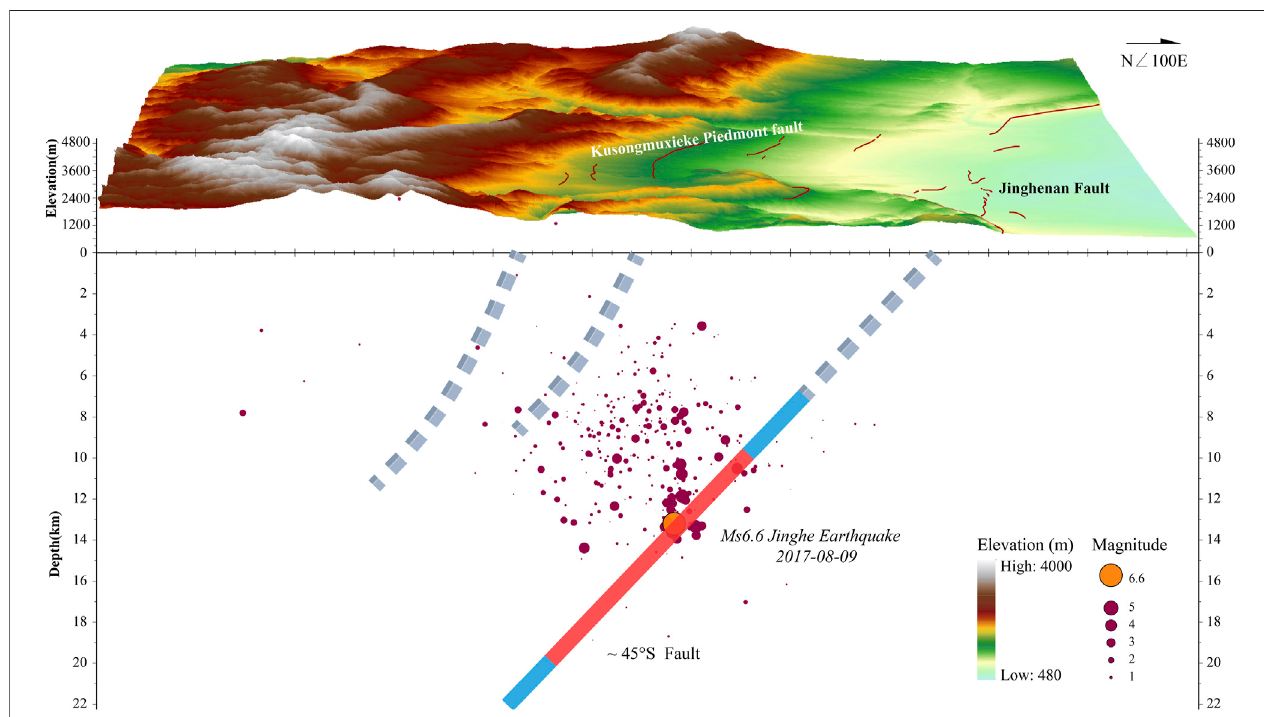
FIGURE 9 | Schematic geometry model of the Jinghe earthquake. The thin red lines denote the active faults. The black arrow points the direction of northeastern 100 ° .Thelargest orangedotindicatesthemainshock.Thedarkred dotsindicatetheaftershocks.Theboldlineindicatesthefaultslipmodel.Theredpartoftheboldline is the main slip. The broken line is the speculative fault extension. The geoid up and geoid down are at the same scale speci fi cally.